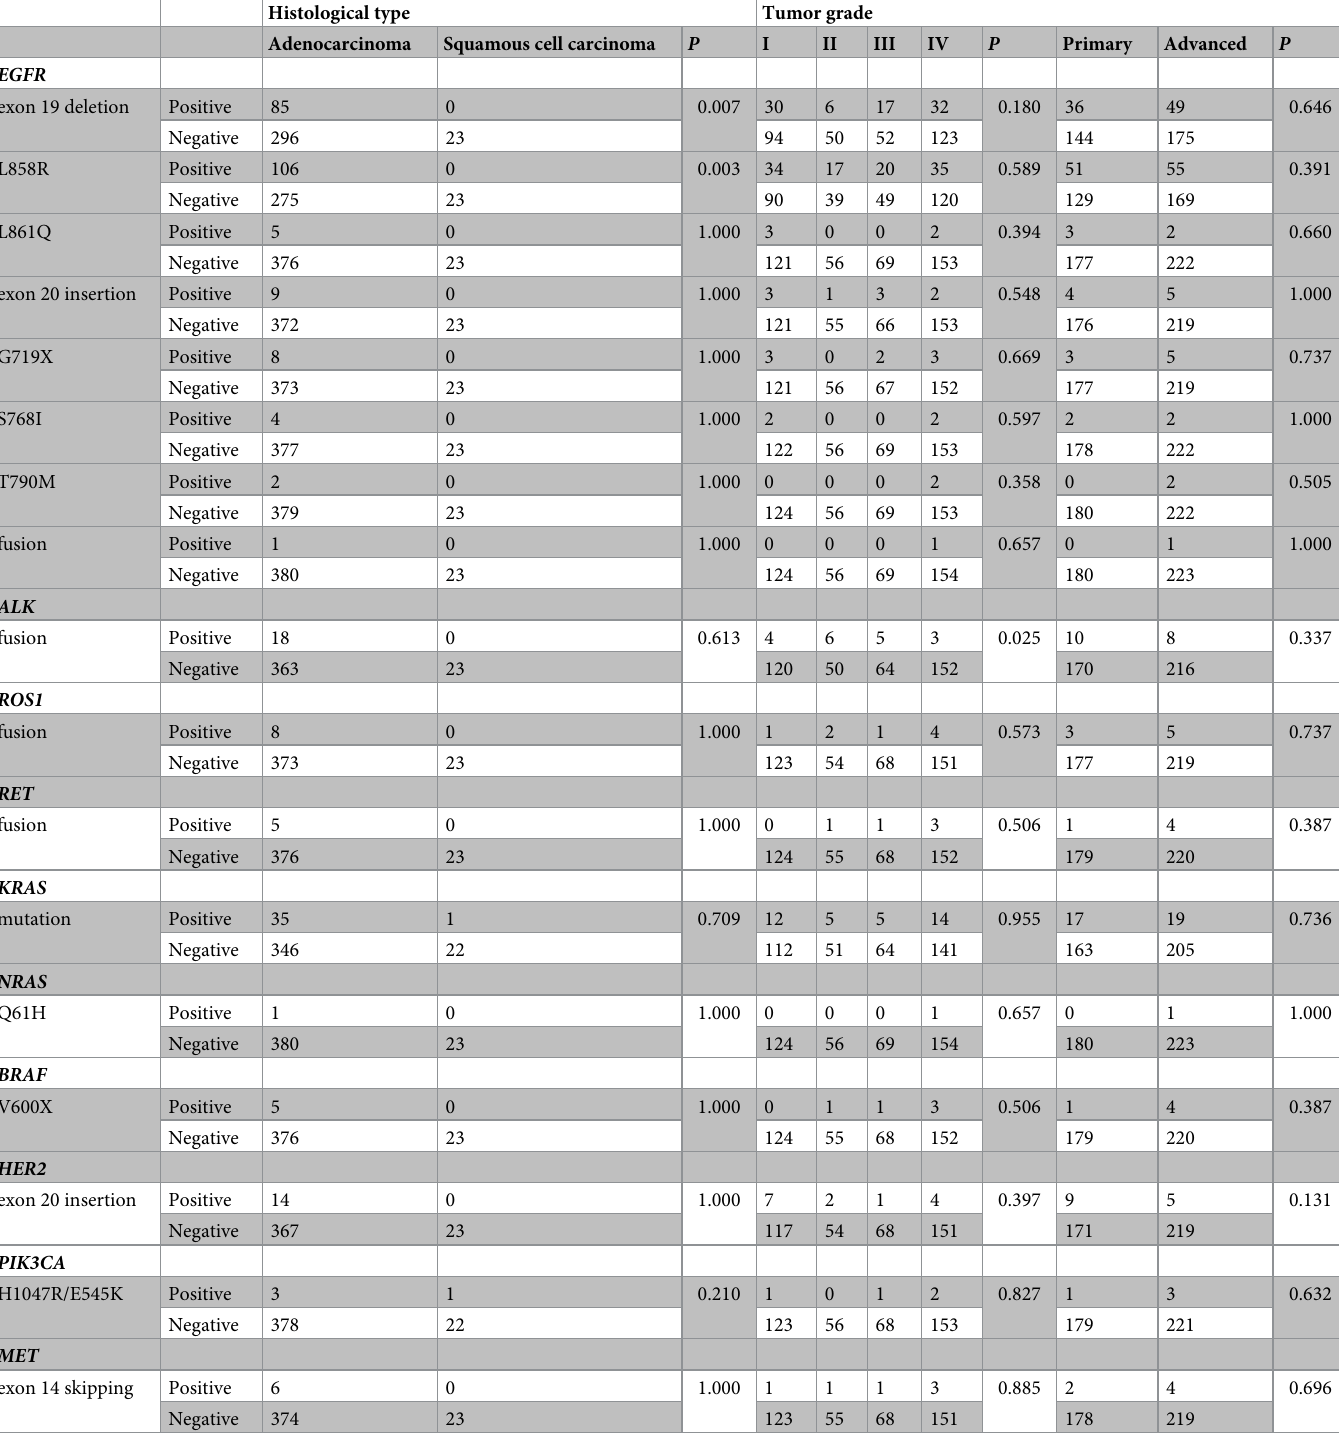
Table 4. Association between genetic variations and tumor